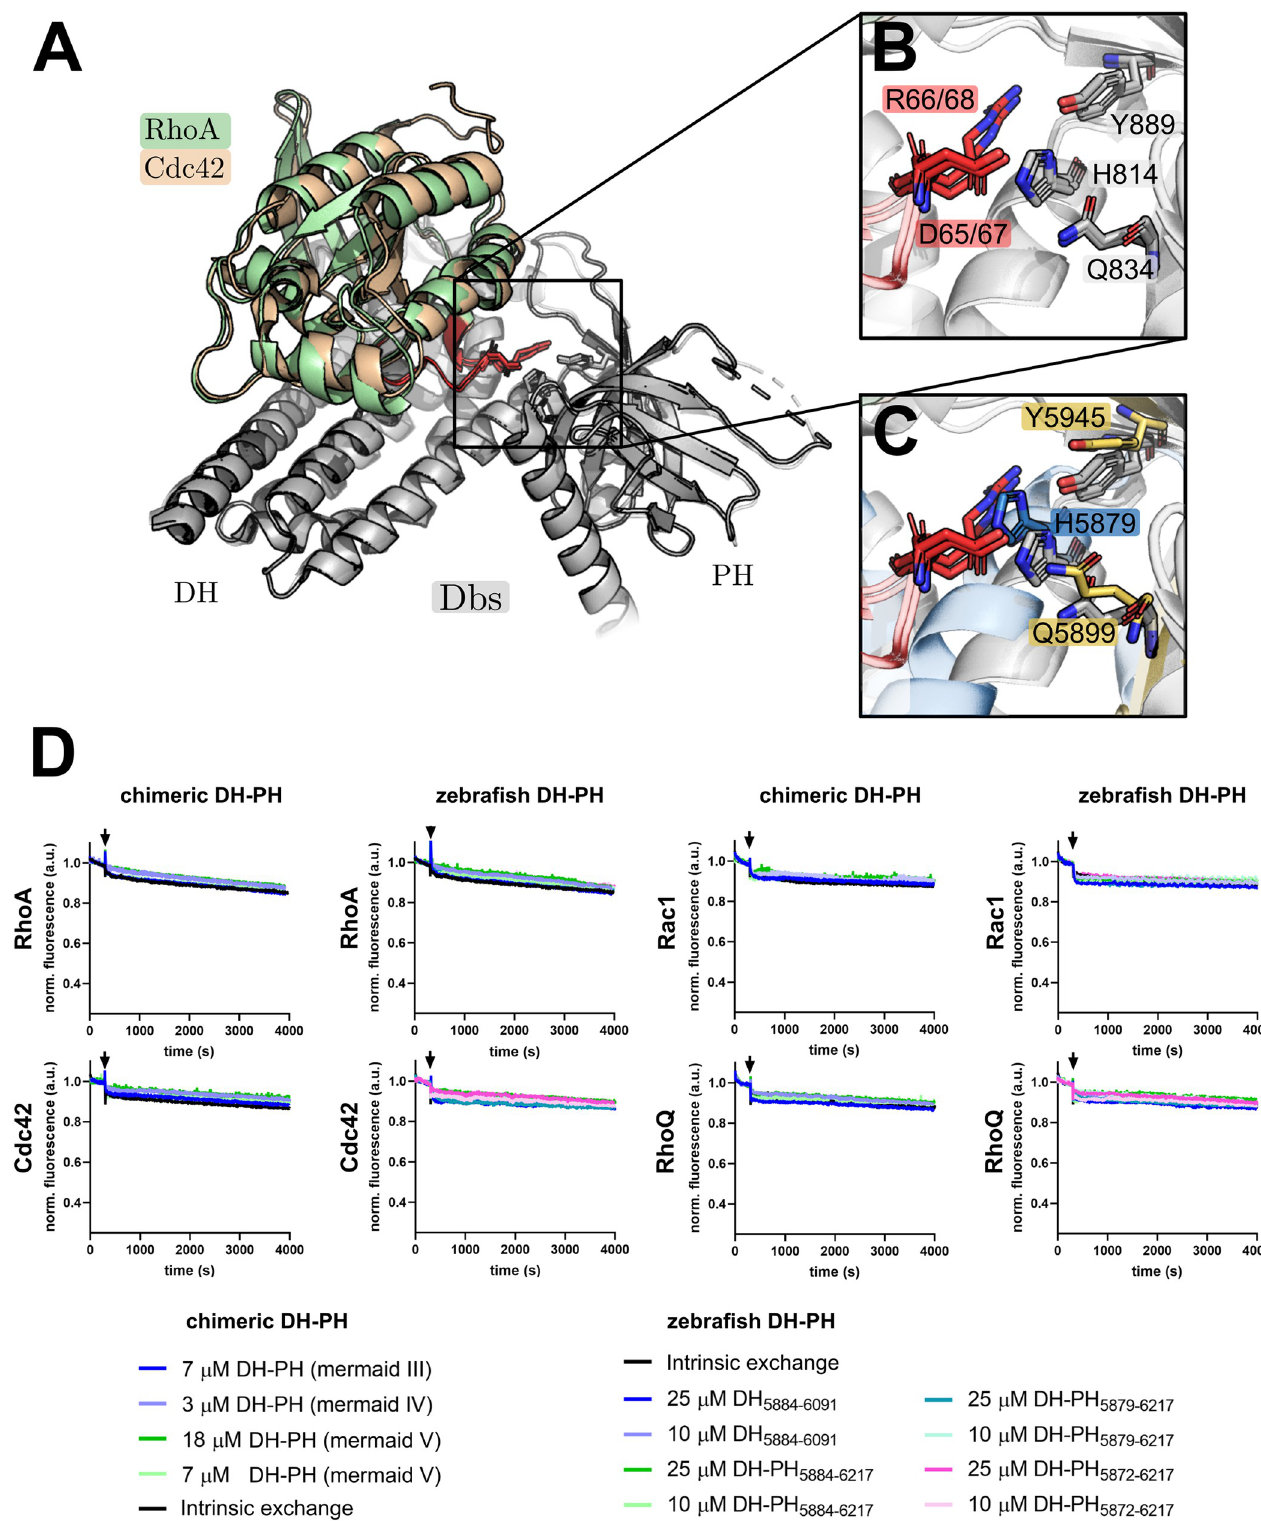
Fig 3. Influence of the obscurin PH domain on nucleotide exchange activity. A-C, Structural determinants of nucleotide exchange activity in Trio-subfamily GEFs. A, the aligned structures of Dbs bound to RhoA (PDB-ID: 1LB1) and Cdc42 (PDB-ID: 1KZ7) show a contact between the DH-PH domain interface and